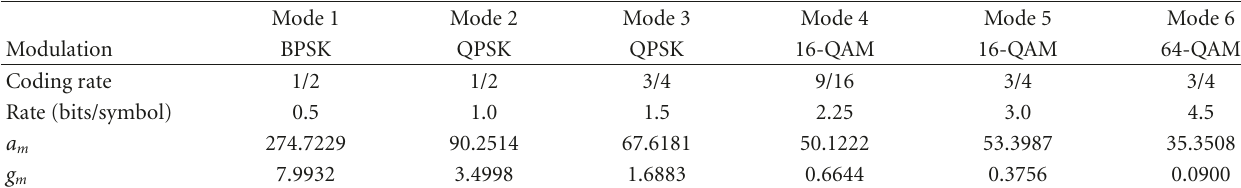
Table 1: Transmission AMC modes with convolutional-coded modulation